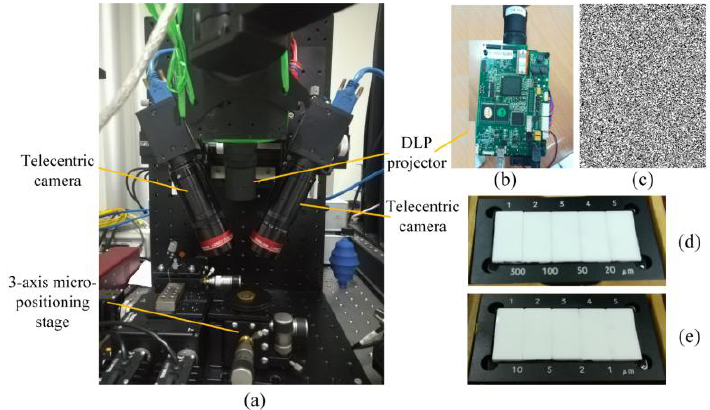
Figure 1. ( a ) The established experimental setup; ( b ) a frontal photo of the projection module; ( c ) the digital random speckle pattern generated by a computer; ( d ) the 516-499 Ceramic Step Master 300C having four designed steps with the nominal values of 20, 50, 100, and 300 µ m; ( e ) the 516-498 Ceramic Step Master 10C having four designed steps with the nominal values of 1, 2, 5, and 10 µ